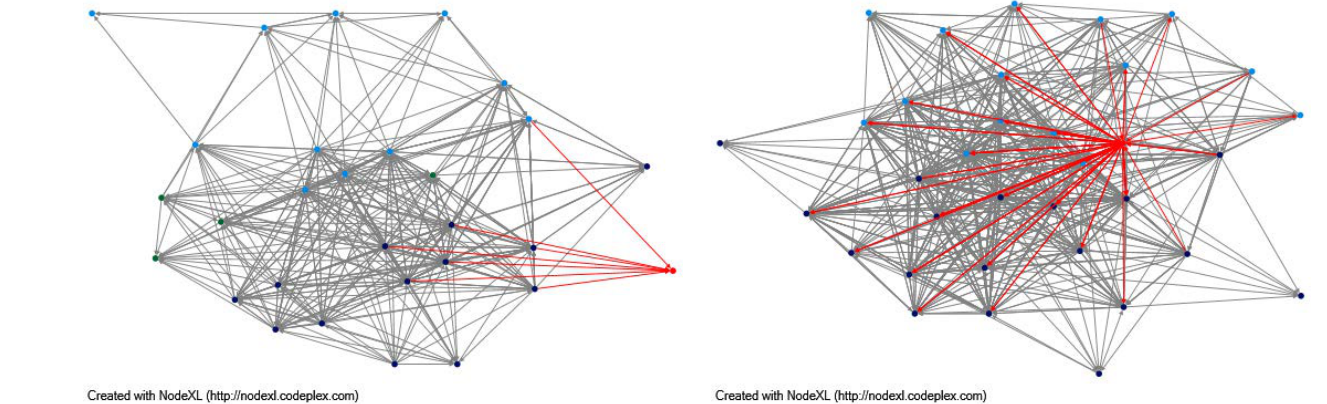
Figure 2a. An egocentric network of a “lurker” (initial four weeks) Gradually mastering member to recognized